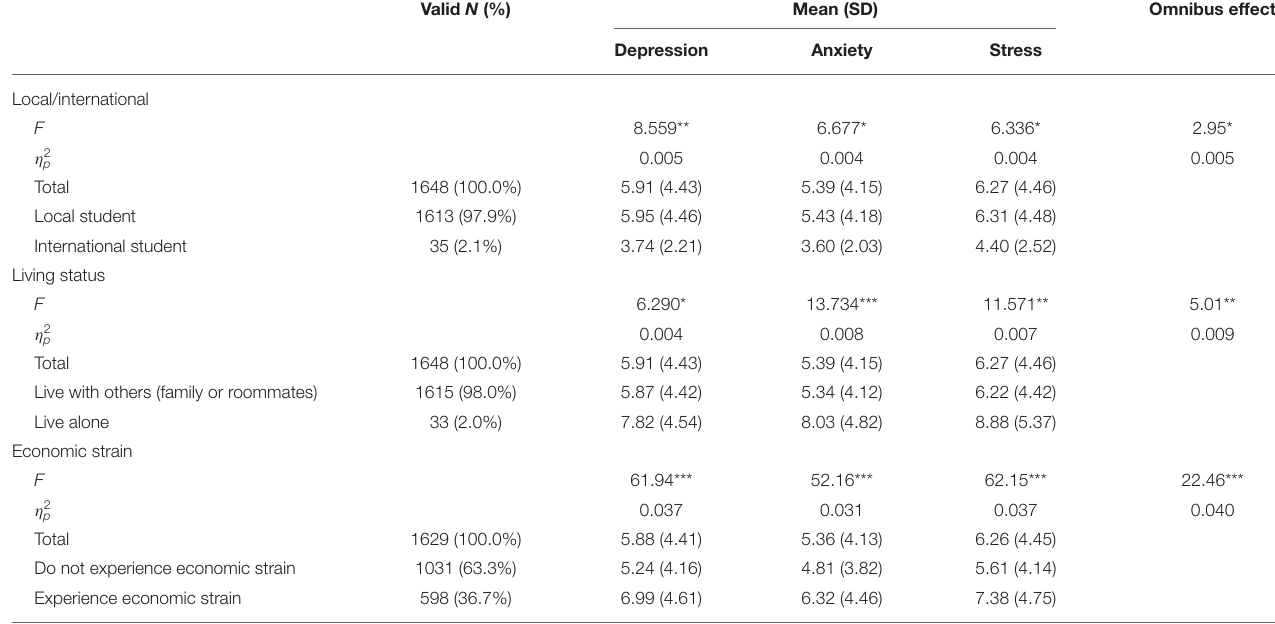
TABLE 3 | Results of